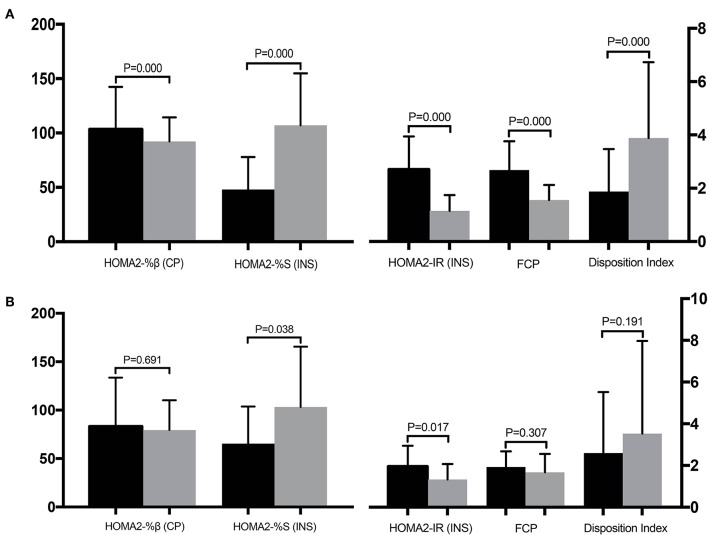
Comparisons of the clinical parameters before (black column) and after (gray column) surgery for the improved (A) and unimproved (B) groups. Pancreatic β-cell function is represented by HOMA2-%β (CP), insulin sensitivity is represented by HOMA2-%S (INS), and insulin resistance is represented by HOMA2-IR (INS).